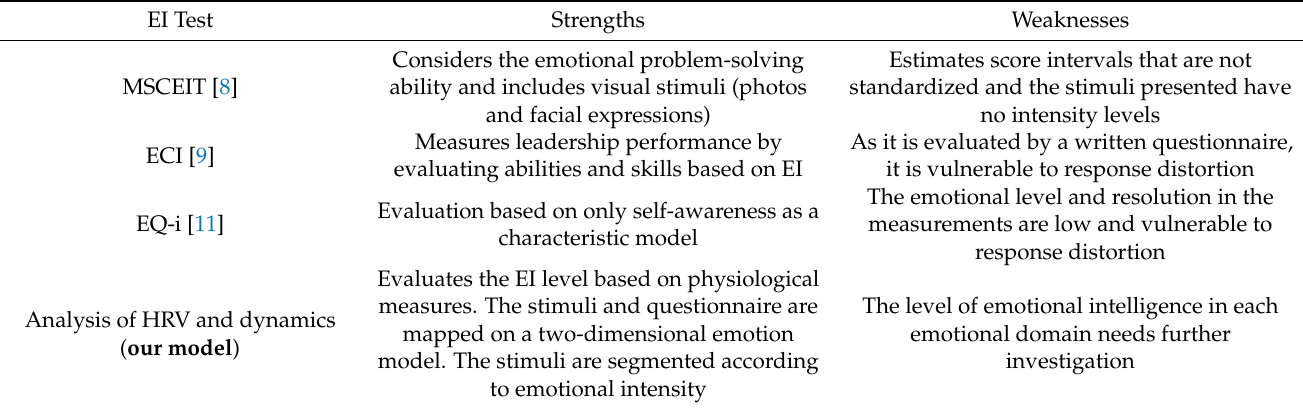
Table 1. The strengths and weaknesses of each EI